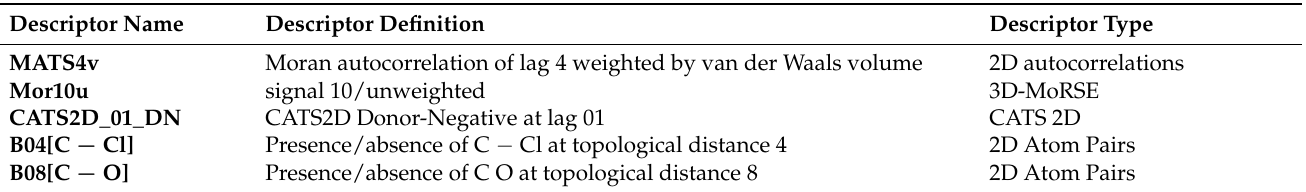
Table 2. Definitions of descriptors included in the five-variable model for prediction of K